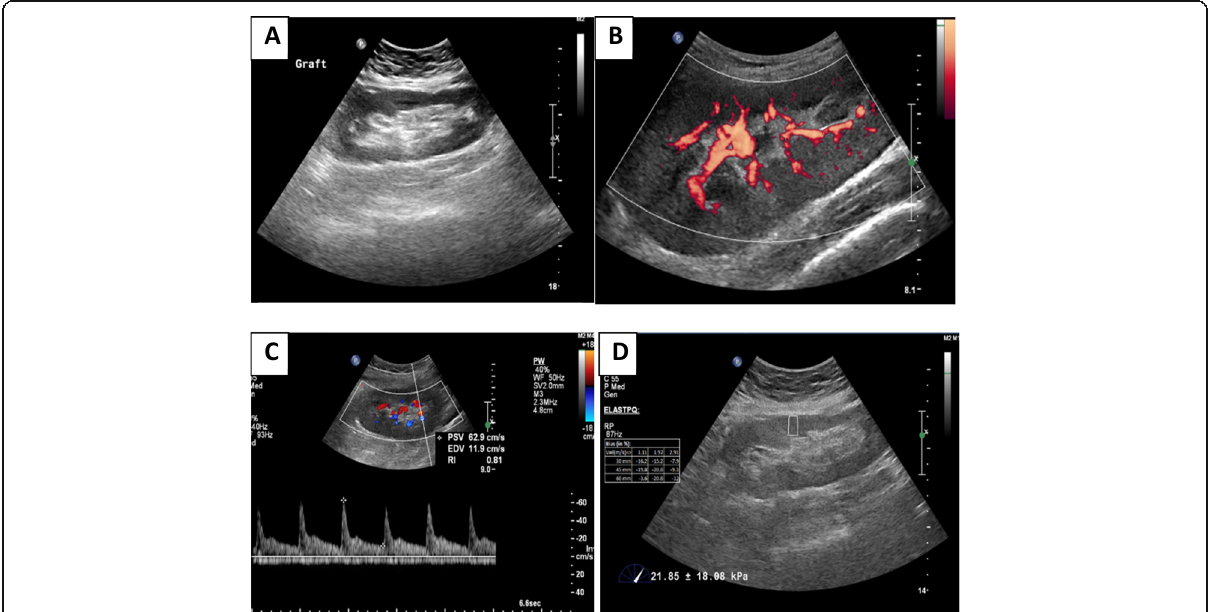
Fig. 2 A 25-year-old female patient who underwent renal transplantation in 2013, during follow-up on 20 November 2017, was presented with creatinine level 1.5 mg/dl and increase calcineurin inhibitors (CNI). a Graft US showed average size graft at the right iliac region with increased echogenicity, no back pressure, and no peri-graft collection. b Power Doppler US shows good cortical perfusion. c Duplex Doppler US shows elevated RI measuring = 0.81. d Mean sono-elastography at transplanted kidney measured 21.85 + 18.08 Kpa. Histopathology diagnosis by the US-guided biopsy: acute tubular necrosis (ATI)